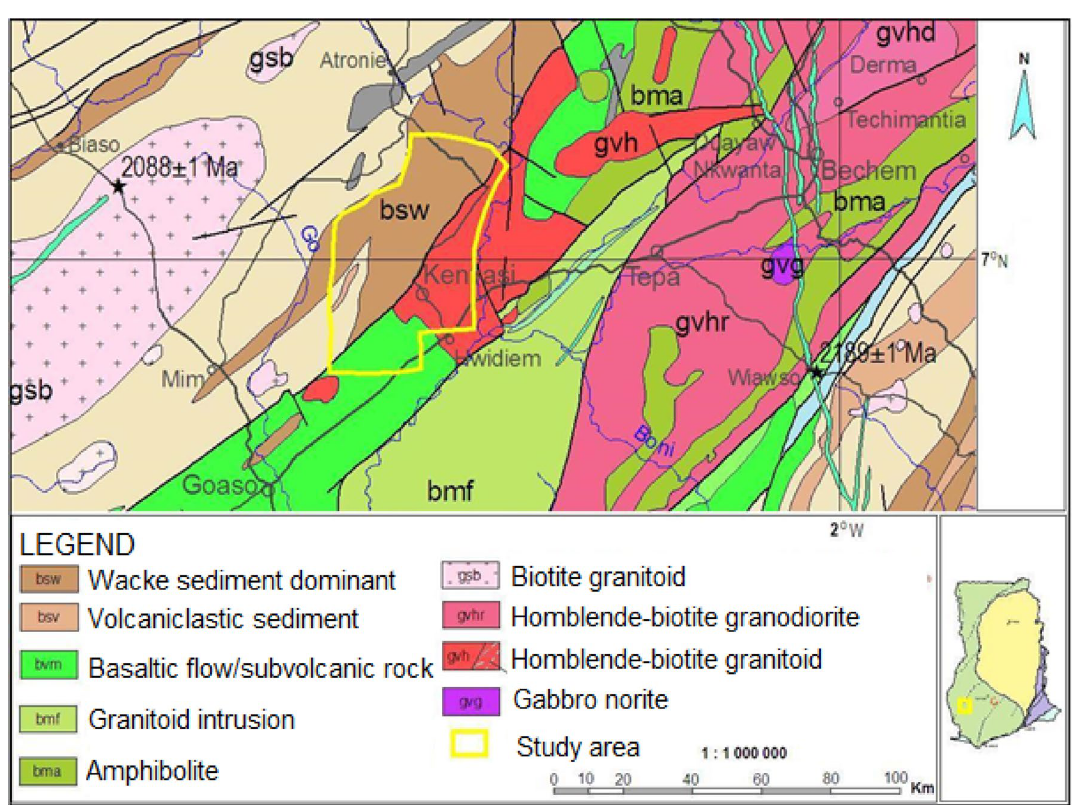
Fig. 2 Geological map of the Asutifi